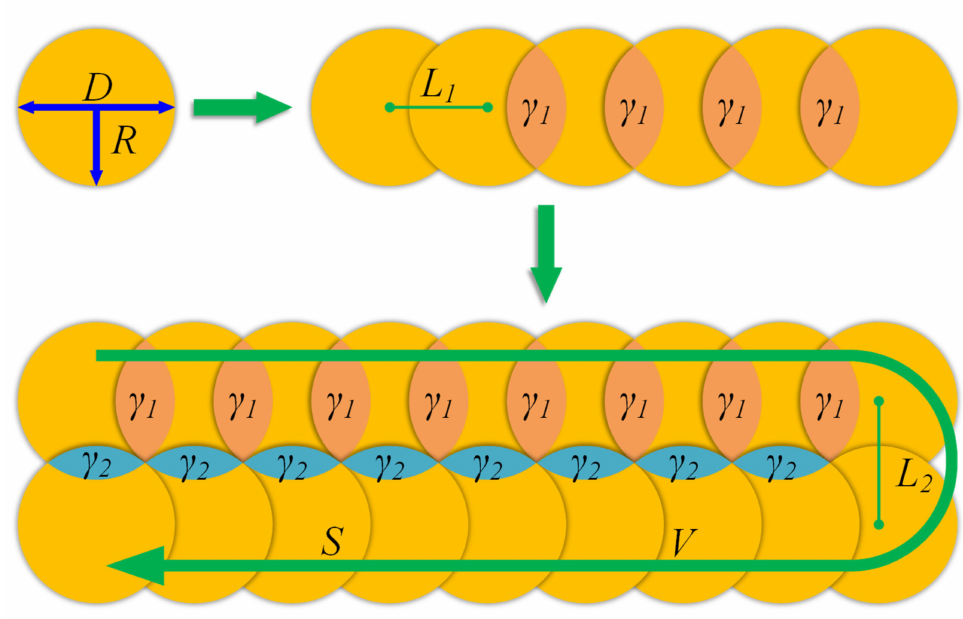
Figure 3. Schematic diagram of the water jet-guided laser cleaning